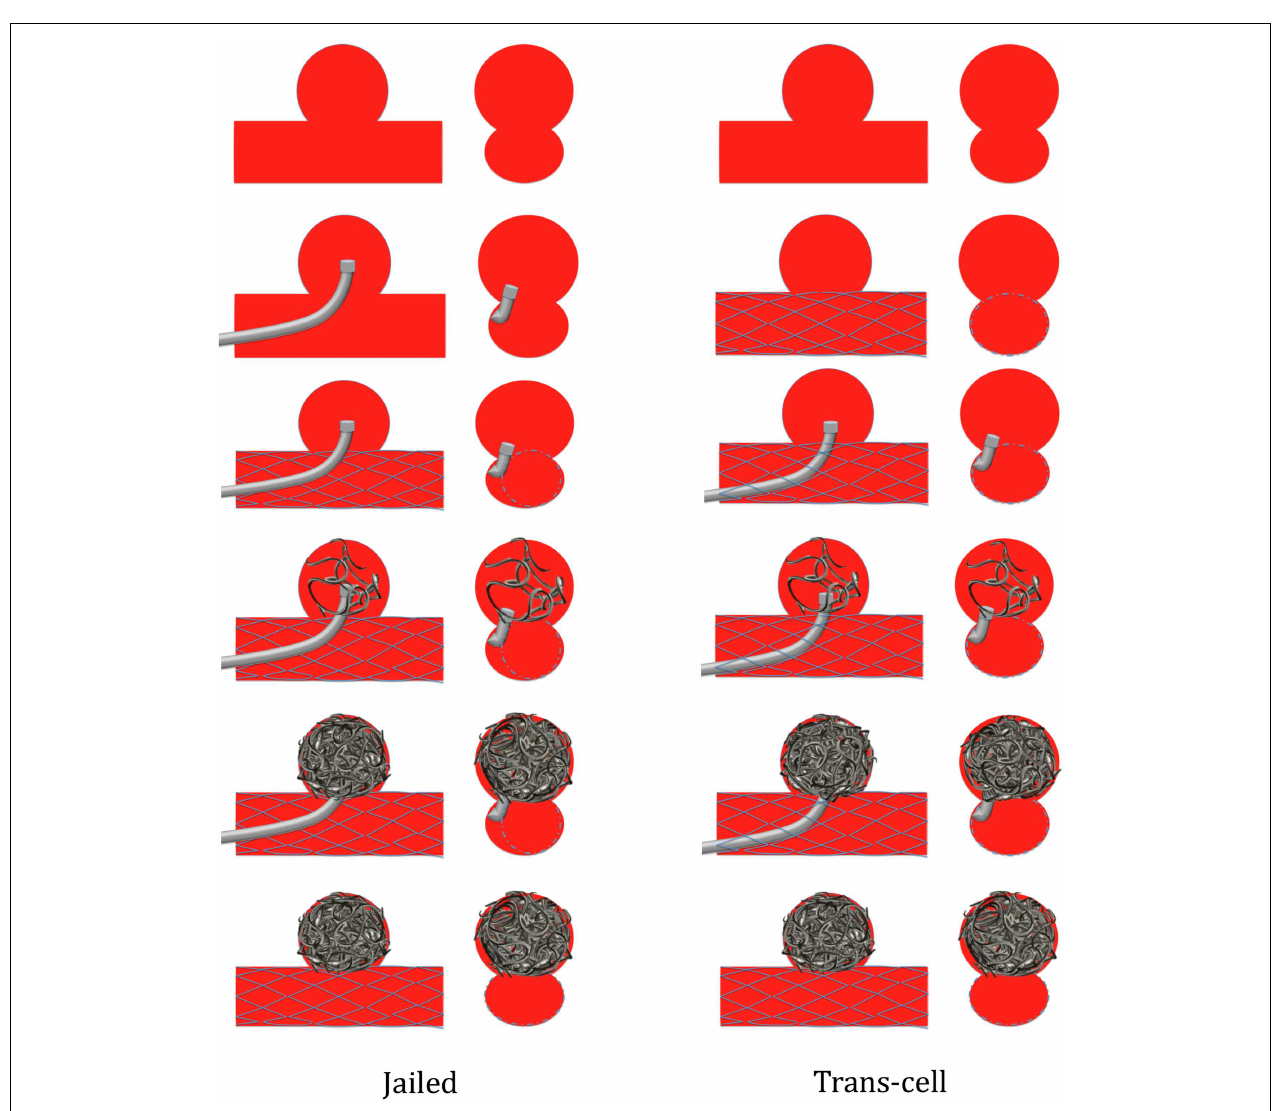
FIGURE 1 | Jailed-catheter and trans-cell techniques